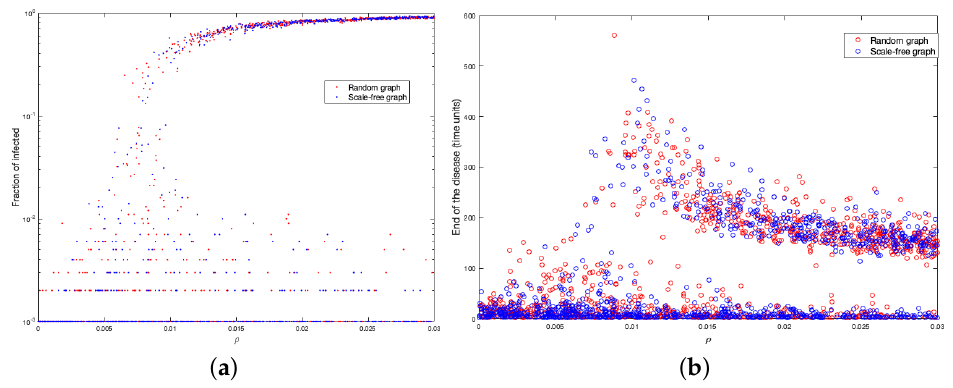
Figure 6. Fraction of infected for different values of ρ ( a ); end of the disease for different values of ρ ( b ).